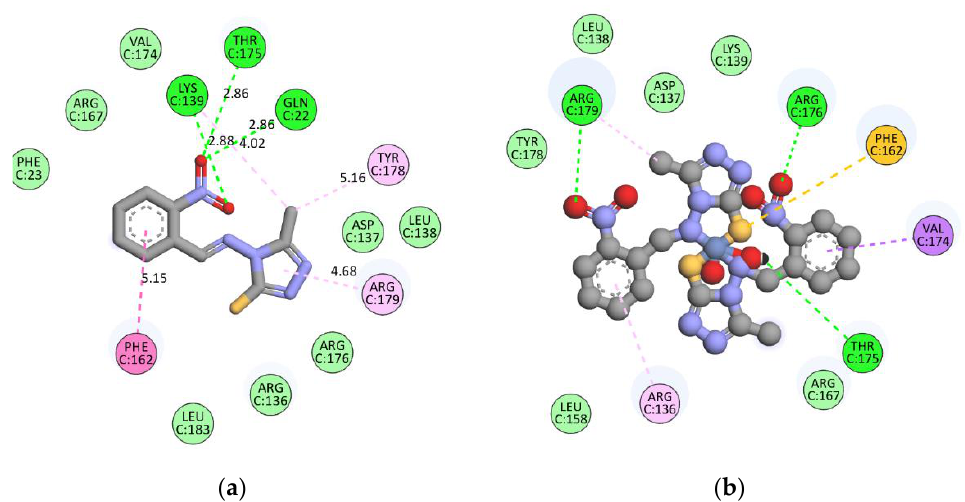
Figure 3. Interactions of ( a ) HL 1 and ( b ) C 1 with amino acids (LYS41 and VAL36).